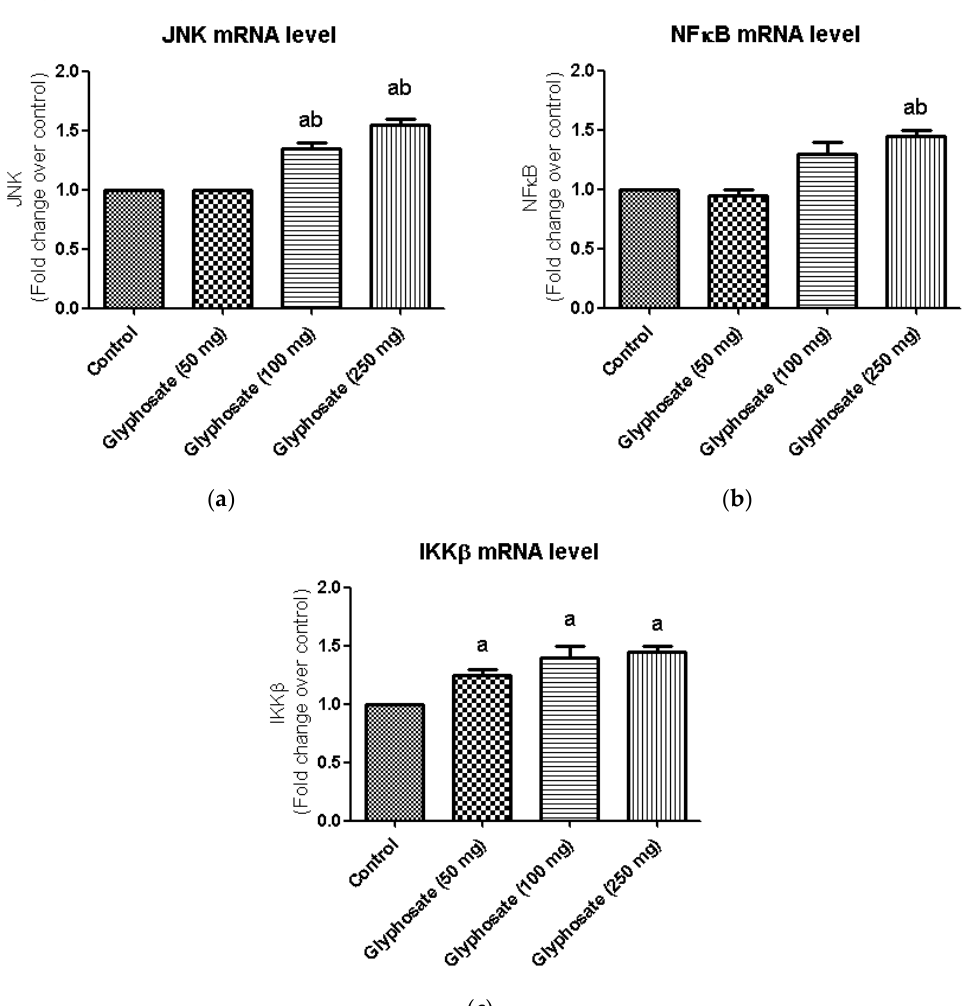
Figure 7. ( a – c ): Impact of glyphosate on the mRNA expression levels of JNK, NF κB and IKKβ in control and glyphosate treated rats. JNK, NF κB and IKKβ mRNA expression were analyzed by Real Time-PCR using gene specific primers and results were expression in fold-change over control. Data were expressed as mean ± SEM where n = 6 rats for each group. Values significant at p < 0.05 were analyzed with a — control, b — glyphosate (50 mg/kg b.wt.).